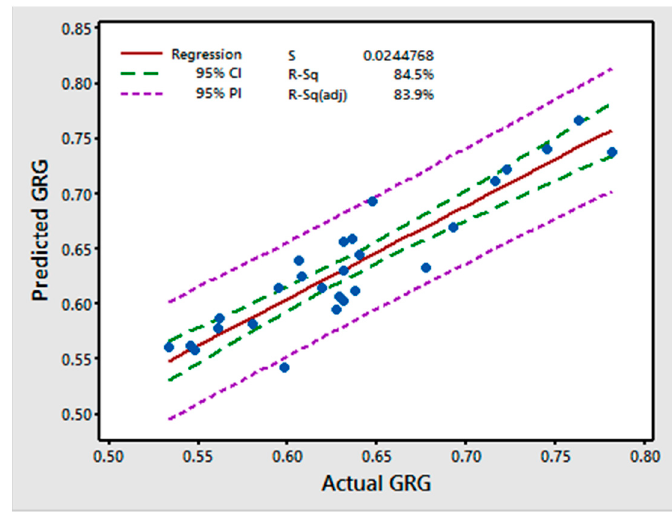
Figure 8. Fitted lines for the actual and predicted GRG.